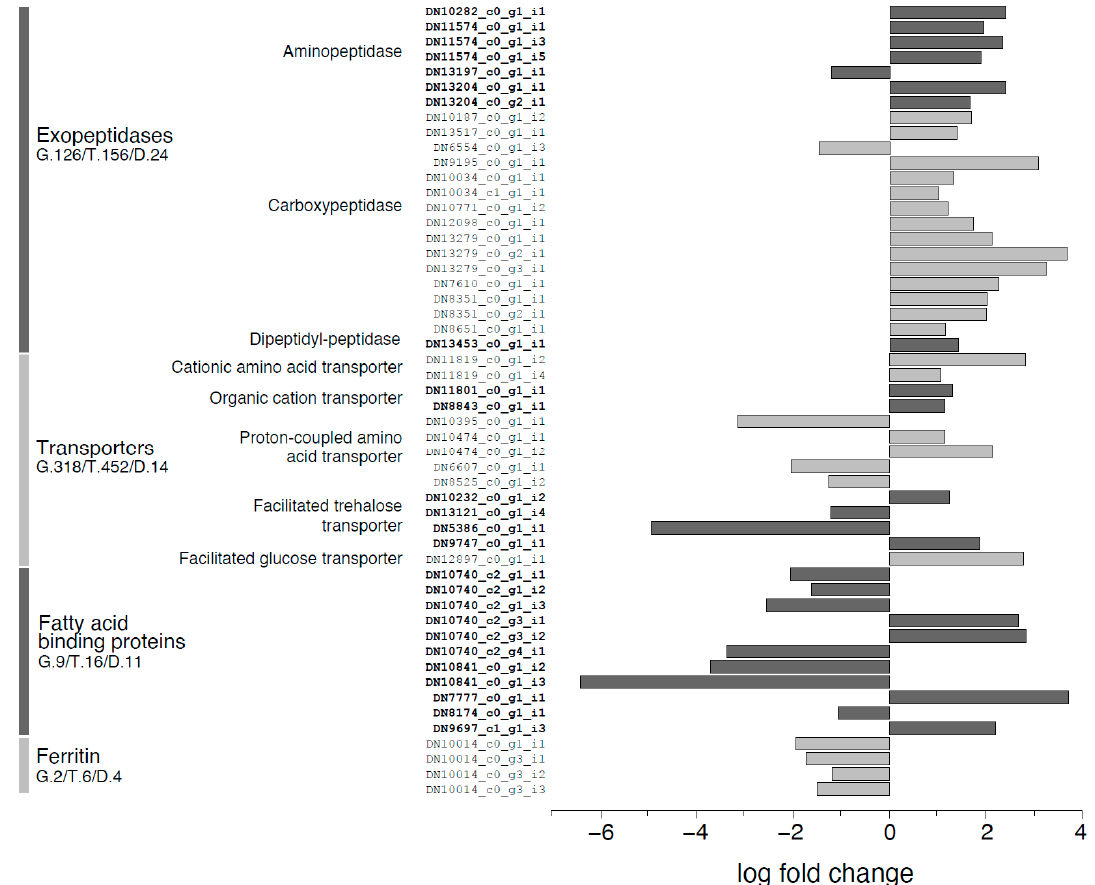
Figure 10. Log fold change of differentially expressed transcripts assigned to molecular functions corresponding to exopeptidases, membrane transport, lipid binding and transport, and iron binding in midguts of larvae reared on VMD compared to SD. For each function the number of genes (G.), transcripts (T.) and transcripts differentially expressed (D.) identified by the transcriptome analysis are shown together with their log fold change in our transcriptomic data.